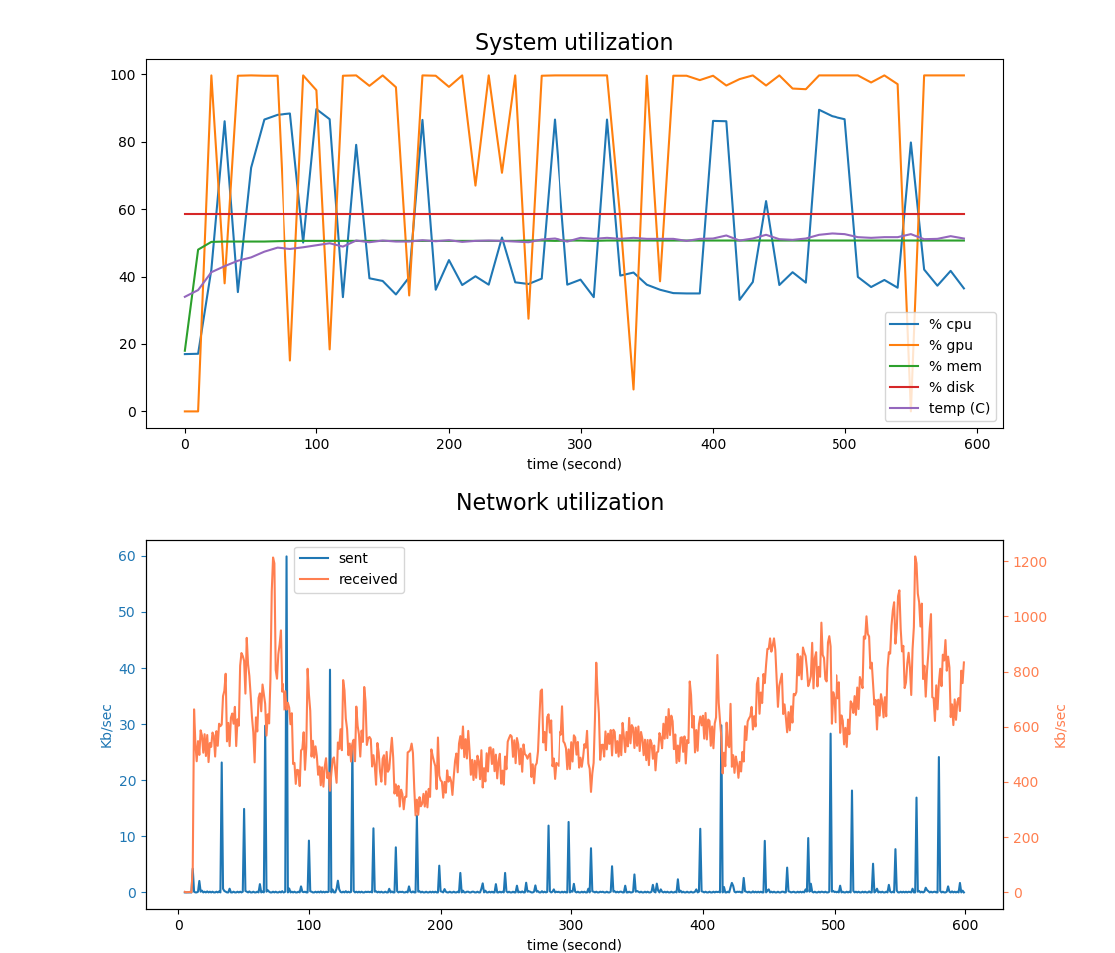
Figure 13. A 15 min monitoring of the CPU, GPU, memory and disk usages, average temperature ( top ) and network utilization ( bottom ) during a real world deployment of the sensor. Over this period, 280 unique objects have been